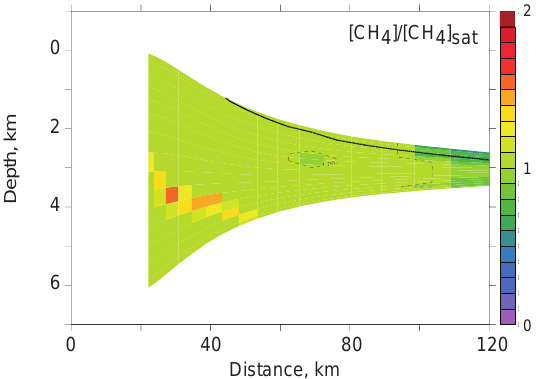
Fig. 11. Methane hydrate concentration, percent pore volume, for the Base scenario with various other scenarios in the Supplement file hydrate.pdf. Solid black line is the stability boundary. Plot- ted with various other scenarios in Fig. 11 (Supplement). Anima- tions can be seen at http://geosci.uchicago.edu/ ∼ archer/spongebob active/hydrate.active.movie.gif.